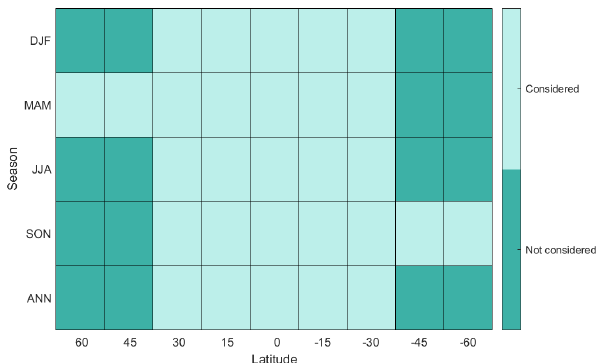
Figure 1. The 29 injection choices that we considered in our anal- ysis for AOD patterns are shown in light green. The vertical axis shows the injection season of each injection choice, either inject- ing in only one season (DJF, MAM, JJA, or SON) or constantly throughout the year (ANN). The horizontal axis shows the injection latitude: from left to right, they are 60, 45, 30, 15 ◦ N, Equator, 15, 30, 45, and 60 ◦